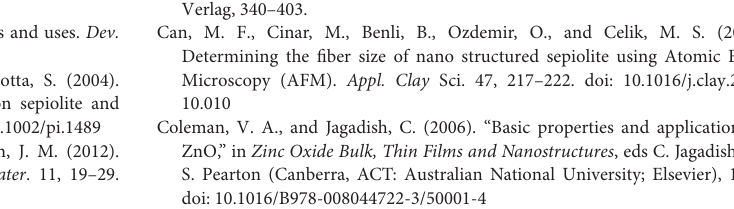
Figure S1 | EDS analysis of the composite